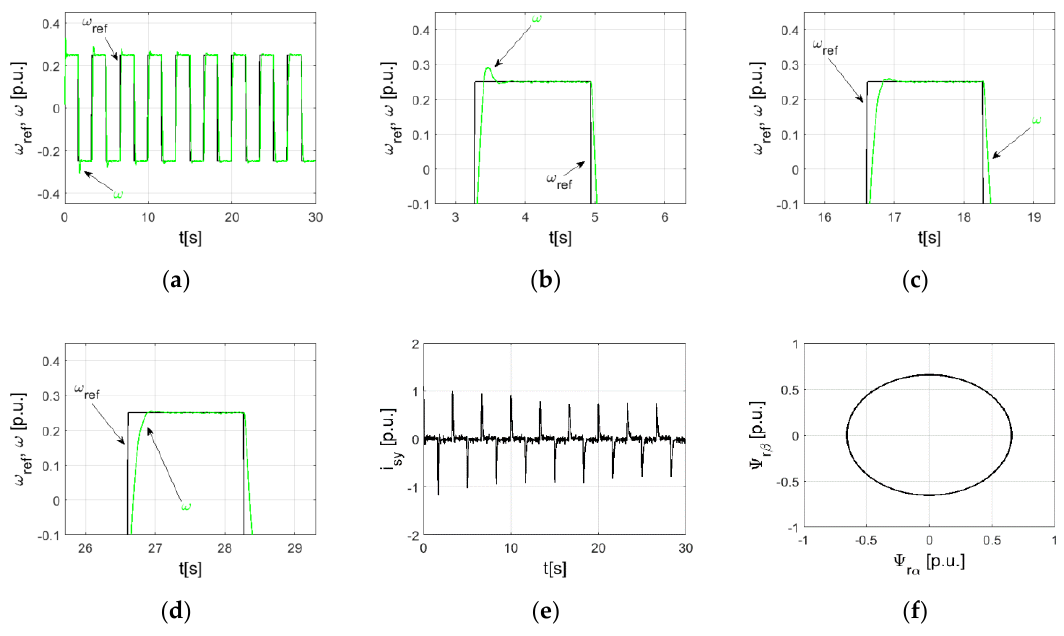
Figure 10. Transients of state variables—speed ( a – d ), component of current ( e ) and hodograph of the rotor flux vector ( f ) observed in the DFOC structure with PI speed controller with neural compensation.